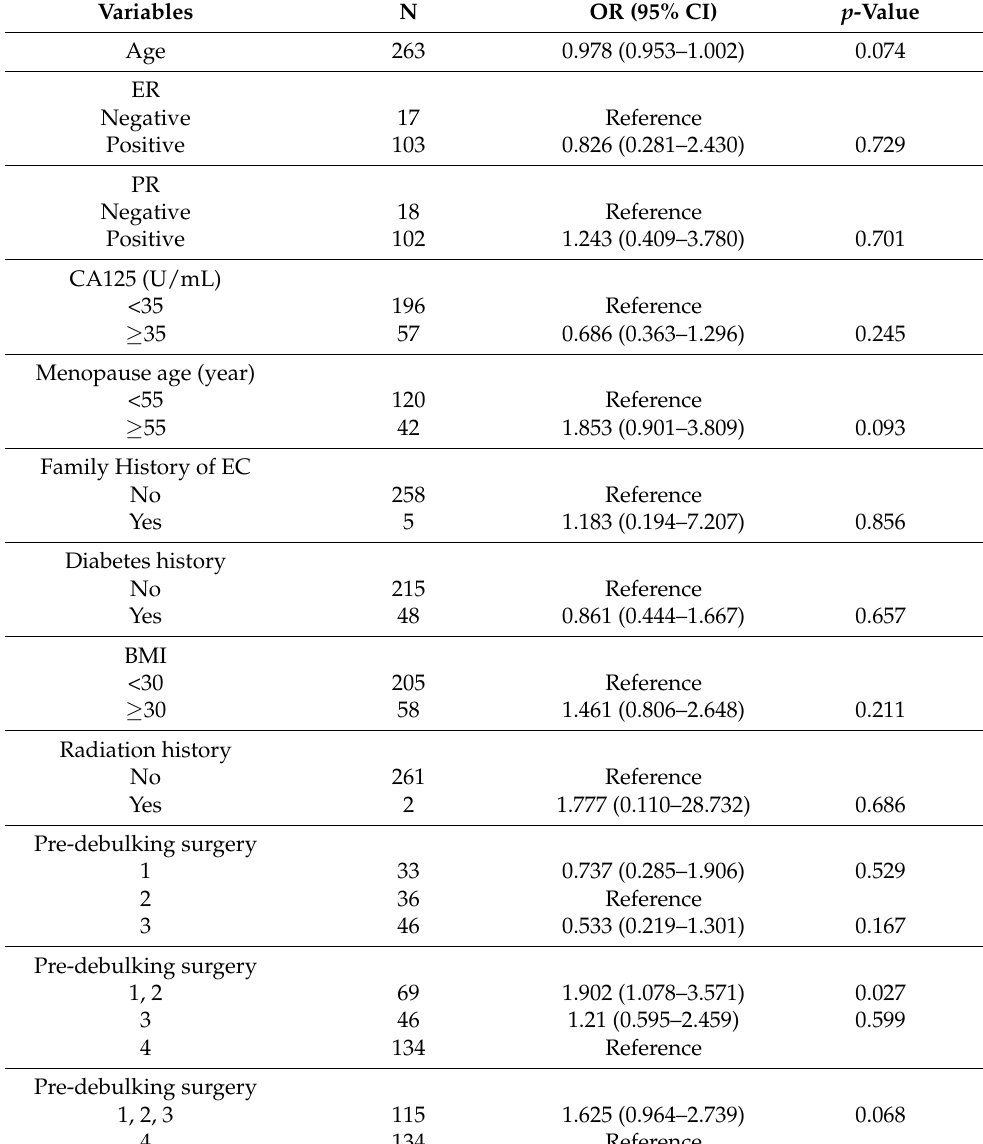
Table 4. Univariate logistic regression analysis of myometrial invasion in